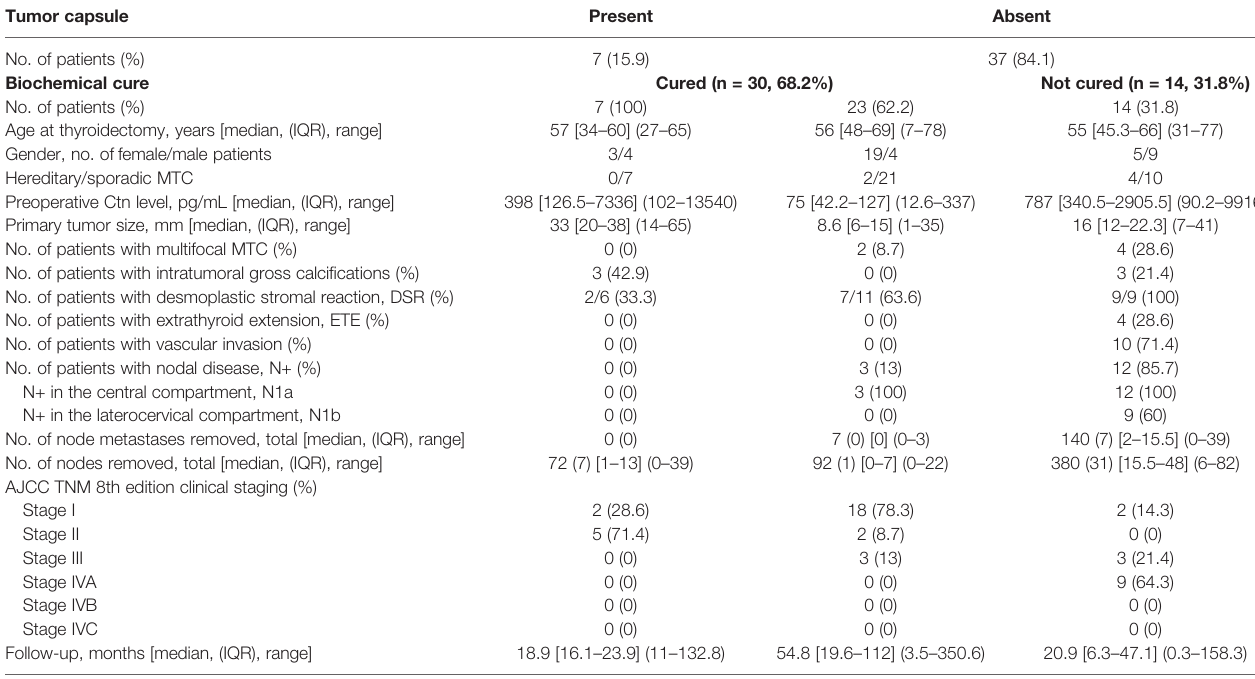
TABLE 2 | Clinical and histopathological characteristics of encapsulated (all cured) and non-encapsulated MTC (cured and not cured). Tumor capsule Present